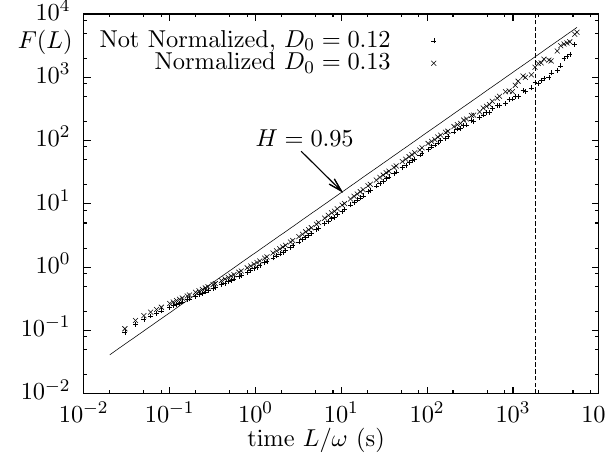
Fig. 9. DFA analysis: comparison of normalized and not normal- ized fluctuations, Eqs. ( 23) and